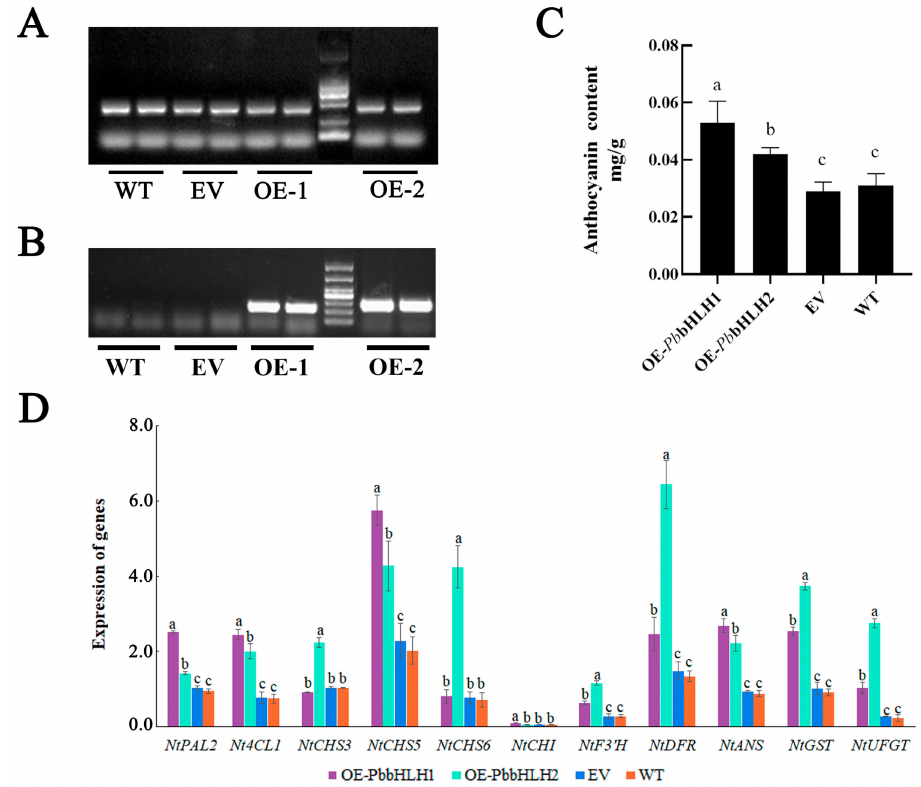
Figure 7. Overexpression of PbbHLH1 and PbbHLH2 increased anthocyanin accumulation in N. tabacum leaves. ( A ) Consistent expression of the internal reference gene actin in the WT, EV, and OE leaves as determined by semiqPCR. ( B ) Relative expression levels of PbbHLH1 and PbbHLH2 in the WT, EV, and OE leaves by semiqPCR. ( C ) The anthocyanin levels in the PbbHLH1 and PbbHLH2 - overexpressing leaves of N. tabacum . At least three independent experiments were performed for each sample, and data are shown as the mean ± SD. Means of different treatment groups (different lowercase letters indicate significant differences) had a significant difference at p ≤ 0.05; ( D ) The expression levels of anthocyanin biosynthesis-related genes in the WT, EV, OE1, and OE2 leaves of N. tabacum leaves. The significant difference threshold was set at p < 0.05. Means of different treatment groups (different lowercase letters indicate significant differences) had a significant difference at p ≤